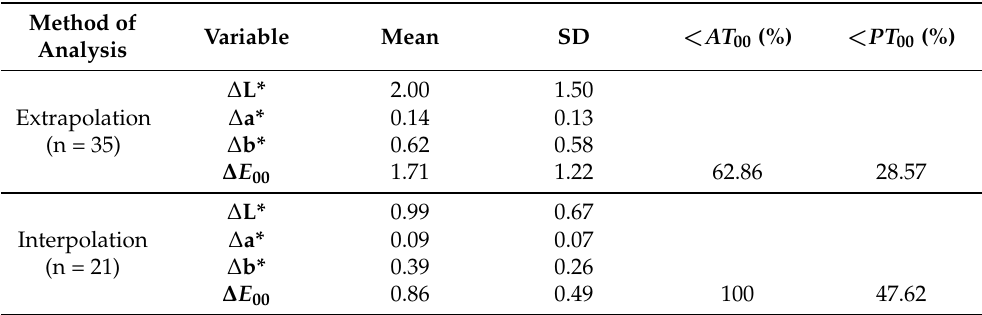
Table 4. Statistics of error metrics for the extrapolation (35 specimens considered for prediction) and interpolation approach (21 specimens considered for prediction).